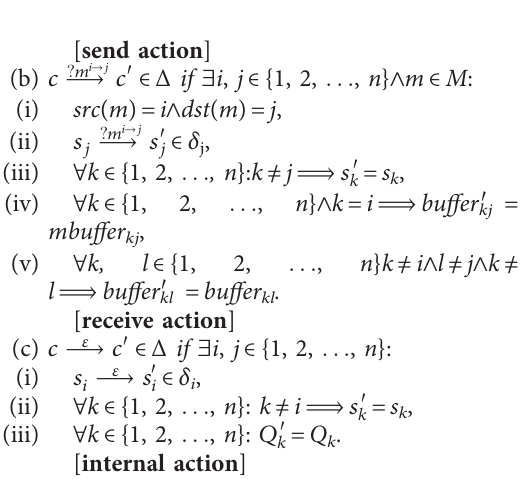
Figure 2: The mailbox